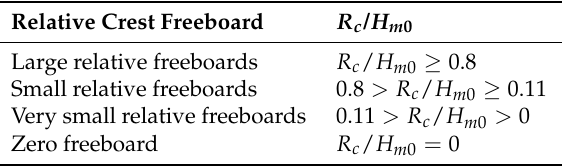
Table 2. Range definition of relative crest freeboards R c / H m 0